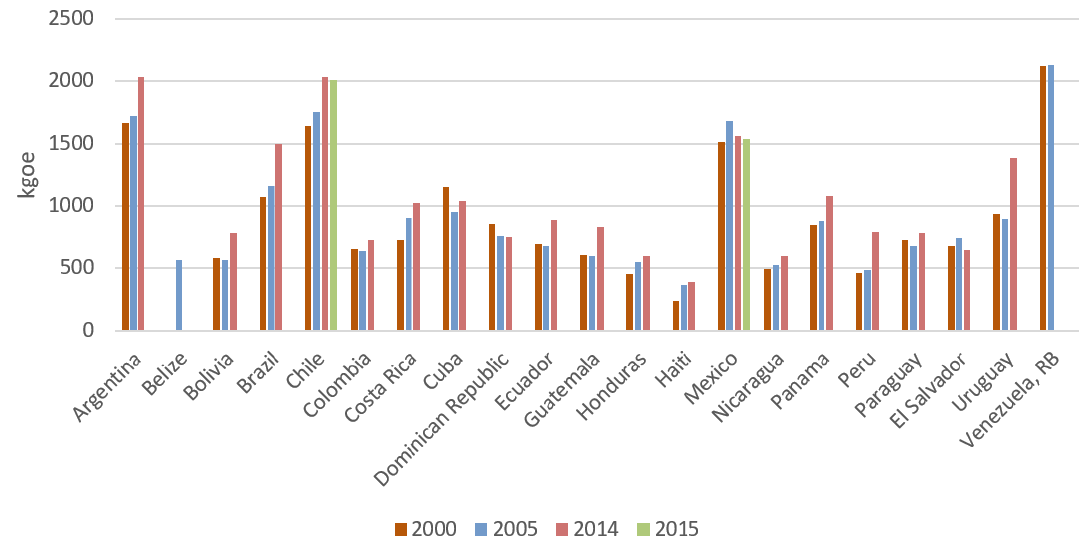
Figure 6. Energy use per year in Latin America [29].